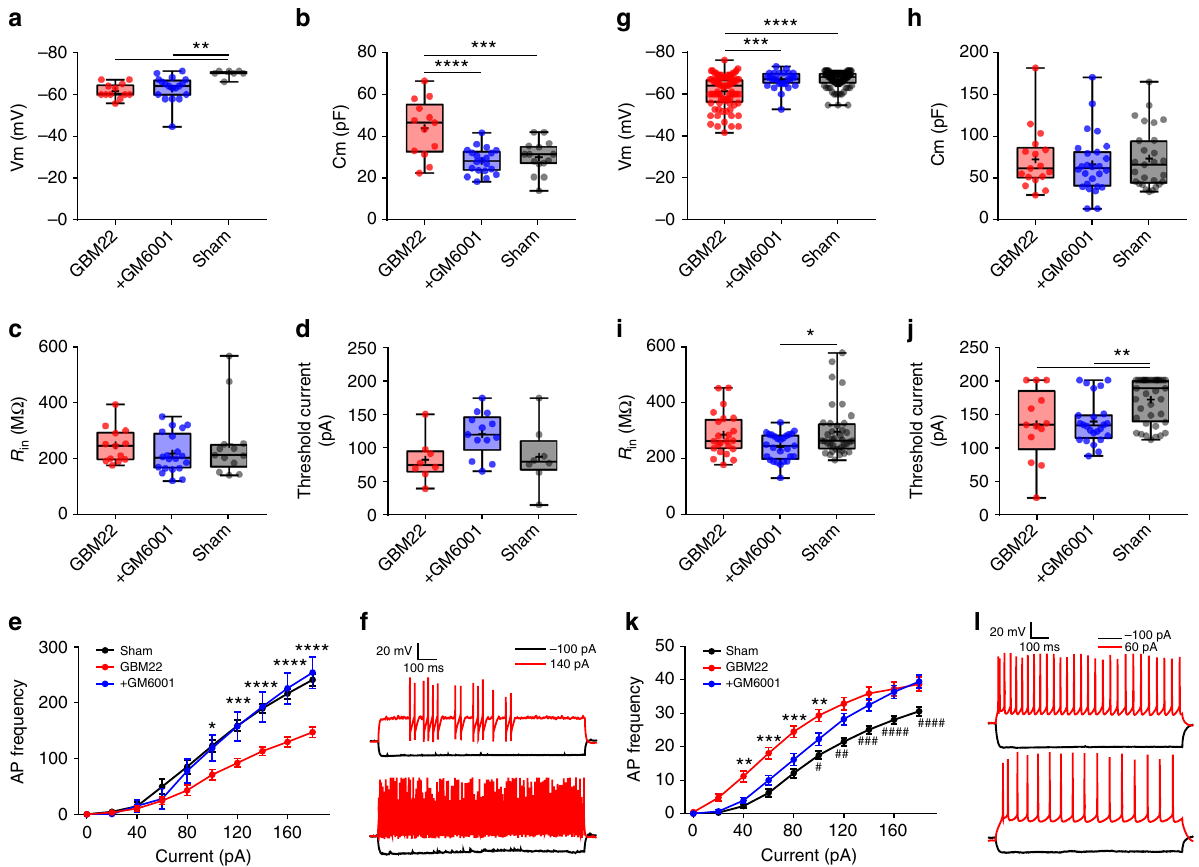
Fig. 7 Electrophysiological properties of inhibitory (FSNs) and excitatory neurons in the PTC of GM6001-treated mice. a Unaltered resting membrane potential (Vm) of FSNs in the PTC of GM6001-treated (62.88 ± 1.40, n = 18(5)) than in nontreated (GBM22) PTC (61.67 ± 1.01, n = 12(8)), but signi fi cantly different than in sham (69.85 ± 0.67, n = 7(6)). b Lower Cm of FSNs in the PTC of GM6001-treated (28.27 ± 1.36, n = 20(5)) than nontreated (43.84 ± 3.74, n = 13(8)), but similar to sham (30.11 ± 1.99, n = 15(6)). c Unaltered R in of FSNs in GM6001-treated PTC (219.90 ± 15.69, n = 20(5)) compared to GBM22 PTC (249.10 ± 17.65, n = 13(9)) and sham (252.64 ± 35.30, n = 13(7)). d Threshold current of FSNs remained unaltered in GM6001- treated PTC (120.76 ± 8.96, n = 13(5)) compared to nontreated PTC (82.75 ± 11.49, n = 8(6)) and sham (87.25 ± 16.06, n = 8(5)). e Higher AP frequency of FSNs in GM6001-treated PTC ( n = 12(5)) than in nontreated PTC ( n = 18(11)) but not than in sham ( n = 10(7)). f Representative Vm traces from nontreated (upper) and GM6001-treated PTC (lower) FSNs on − 100pA (black) and 140pA (red) current steps. g Resting membrane potential (Vm) of excitatory neurons in GM6001-treated PTC (66.62 ± 0.77, n = 27(8)) remained similar to sham (67.02 ± 0.38, n = 98(15)), but was signi fi cantly higher than the nontreated PTC (61.49 ± 0.86, n = 80(11)). h Cm of excitatory neurons in GM6001-treated PTC remained unaltered (PTC, 72.90 ± 8.92, n = 17 (10); GM6001-treated PTC, 67.00 ± 6.95, n = 26(8); sham, 73.93 ± 6.95, n = 27(10)). i Input resistance ( R in ) of excitatory neurons in GM6001-treated PTC (244.64± 9.24, n = 27(6)) was not signi fi cantly different than in nontreated PTC (288.18 ± 15.82, n = 23(10)), but than in sham (298.63 ± 14.47, n = 39(10)). j Lower threshold current in excitatory neurons in nontreated PTC (134.76± 14.69, n = 13(8)) than in GM6001-treated PTC (138.75 ± 6.81, n = 24 (8)) and sham (171.33 ± 5.28, n = 39(10)). k Higher AP ( fi ring) frequency of excitatory neurons in GM6001-treated PTC ( n = 25(5)) than in nontreated PTC ( n = 27(10)) and in sham ( n = 36(10)). l Representative Vm traces from nontreated PTC (upper) and GM6001-treated PTC (lower) excitatory neurons on − 100pA and 60pA current steps. n = cells(mice) in all. The units for membrane potential (Vm), threshold current, membrane capacitance (Cm) and input resistance ( R in ) are mV, pA, pF, and M Ω , respectively. **** P < 0.0001, *** P < 0.001, ** P < 0.01, * P < 0.05, one-way ANOVA in ( a − d , g − j ); two-way ANOVA in ( e , k ) (GM6001-treated vs. nontreated); Tukey's post-hoc test in all. #### P < 0.0001, ### P < 0.001, ## P < 0.01, # P < 0.05, two-way ANOVA, Tukey ’ s post-hoc test in ( k ) (GM6001-treated vs.